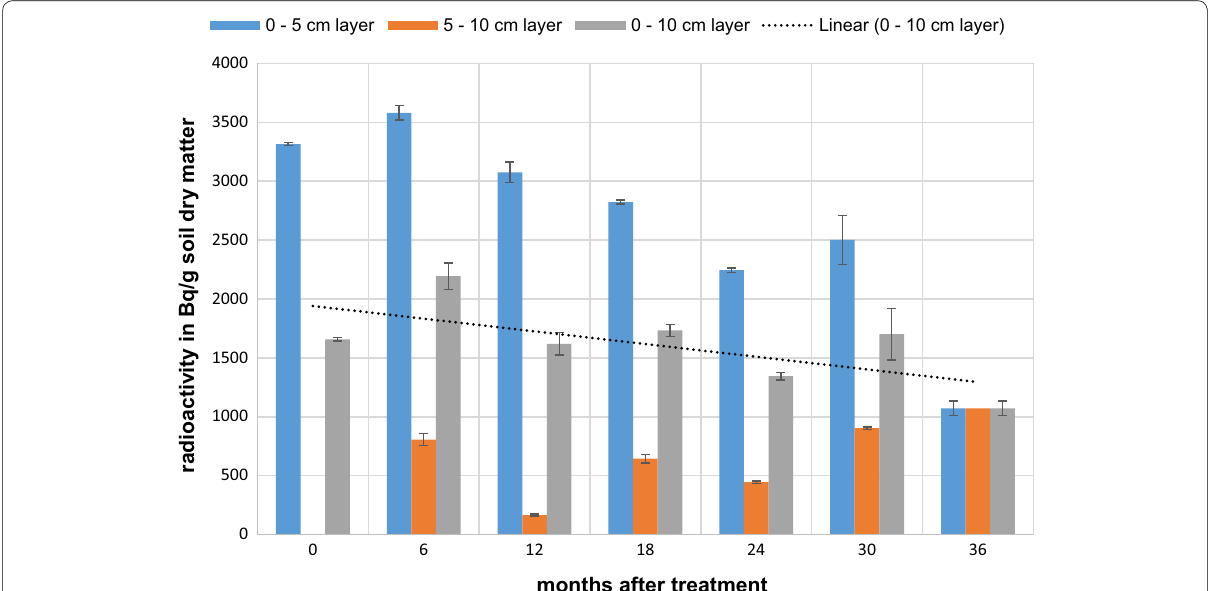
Fig. 5 Concentration of radioactivity (Bq/g soil dw) in soil layers at various sampling days after treatment. Dotted line: linear presentation of results for the 0–10 cm